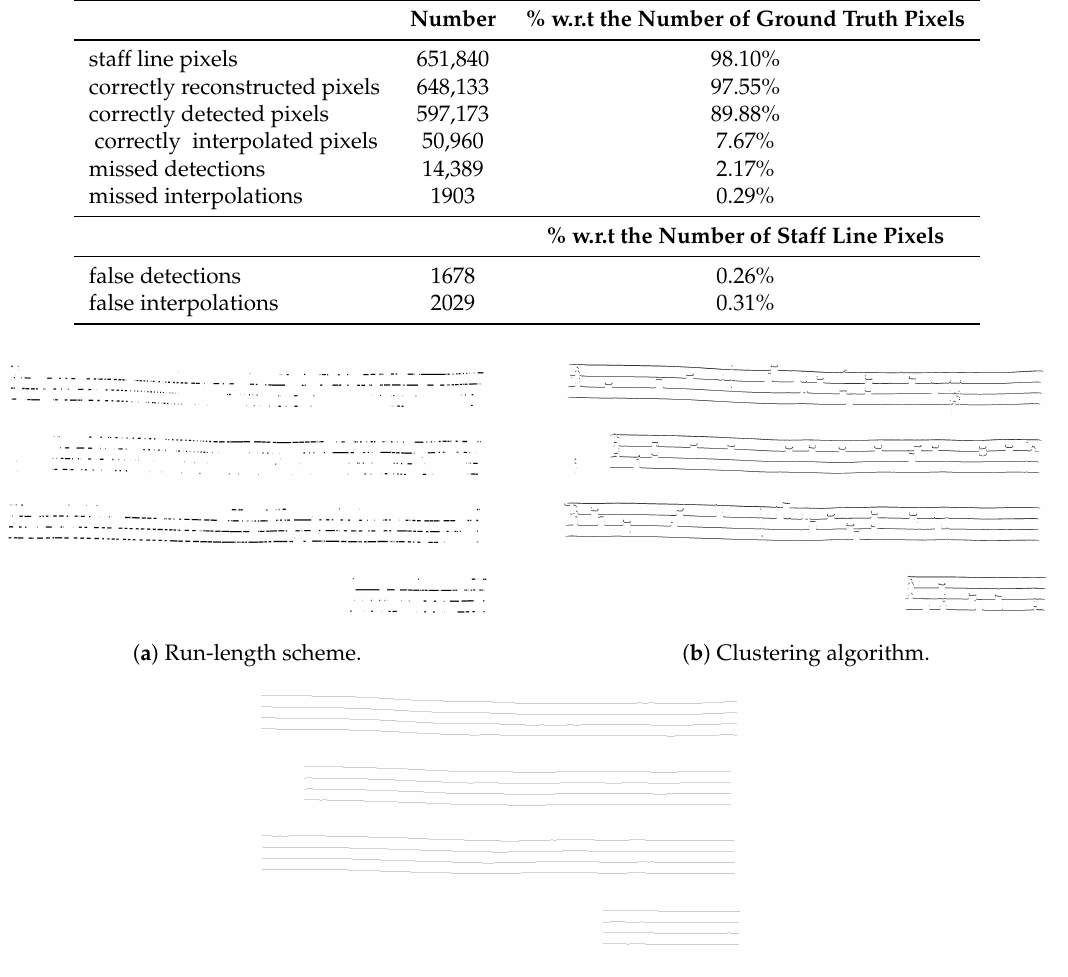
Table 3. Evaluation results.